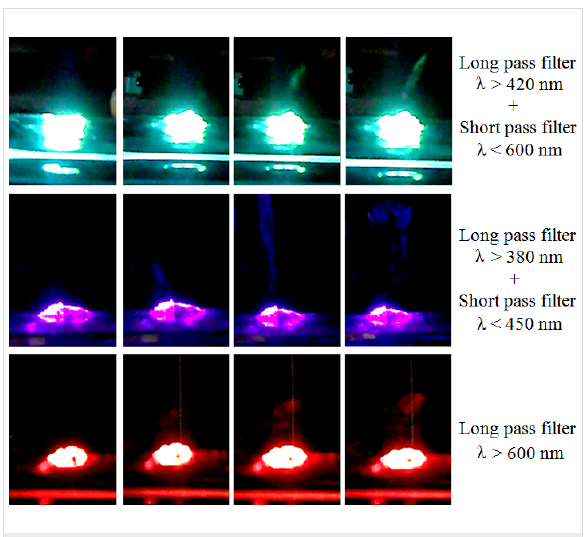
Figure 14: Frames extracted from videos recorded during ignition tests. The variable visible color of the incident light on the sample is due to the different wavelenght ranges selected by the optical filters. For each test, ignition was